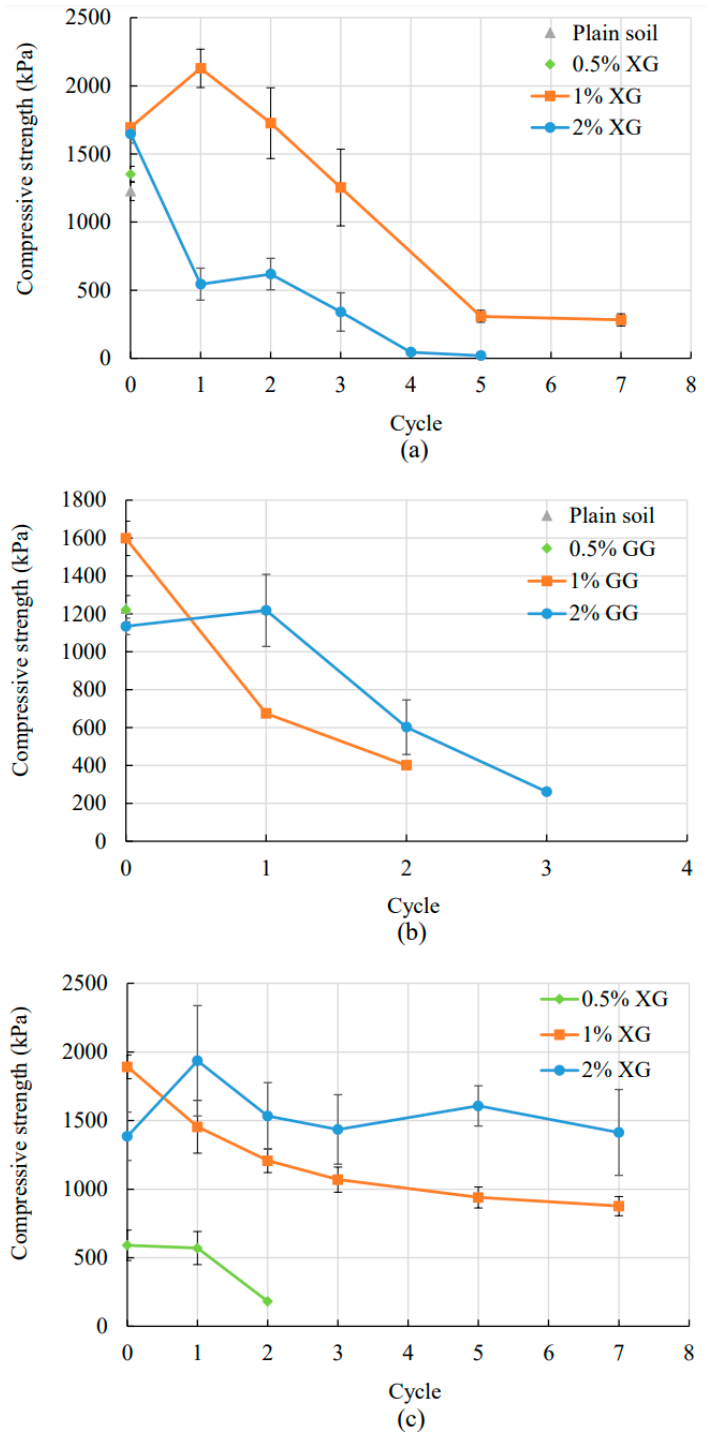
Figure 5. Change in compressive strength for ( a ) Silty sand — XG, ( b ) Silty sand — GG, ( c ) Clean sand — XG.